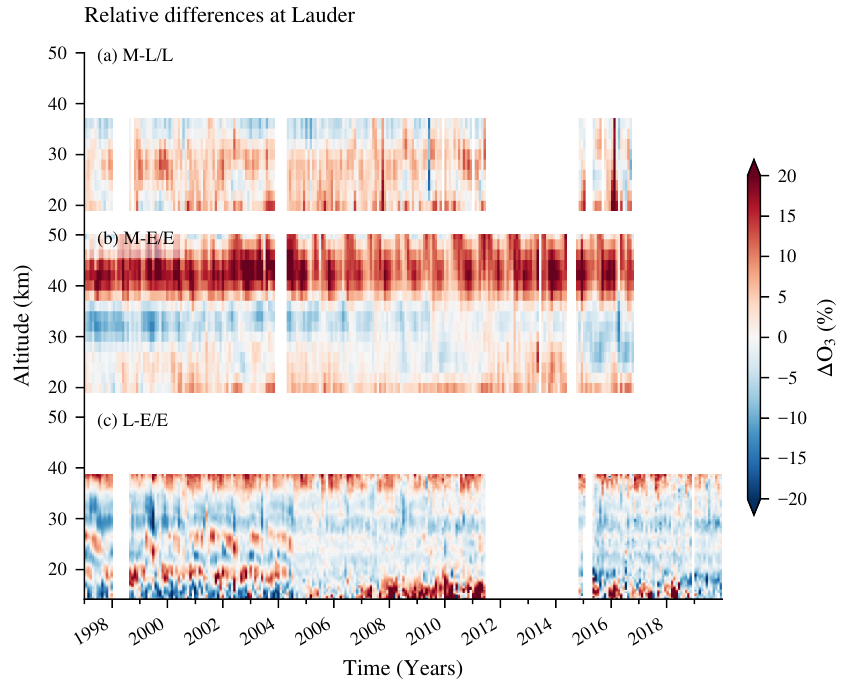
Figure 2. Relative ozone differences between ( a ) MWR (M) and lidar (L) data, ( b ) MWR and ERA5 (E) data, and ( c ) lidar and ERA5 data. Lidar and ERA5 profiles in ( a,b ) have been convolved with MWR averaging